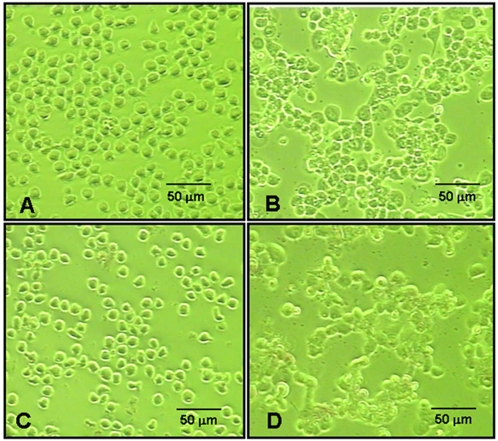
Effect of FePro labeling on THP-1 cell differentiation.THP-1 cells were labeled with FePro complexes and then differentiated in the presence of 100 nM of TPA for 24 h. Phase contrast photomicrograhs of non-labeled THP-1 cells before (A) and 24 h after incubation with 100 nM of TPA (B). FePro labeled THP-1 cell before (C) and 24 h after incubation with 100 nM of TPA (D).